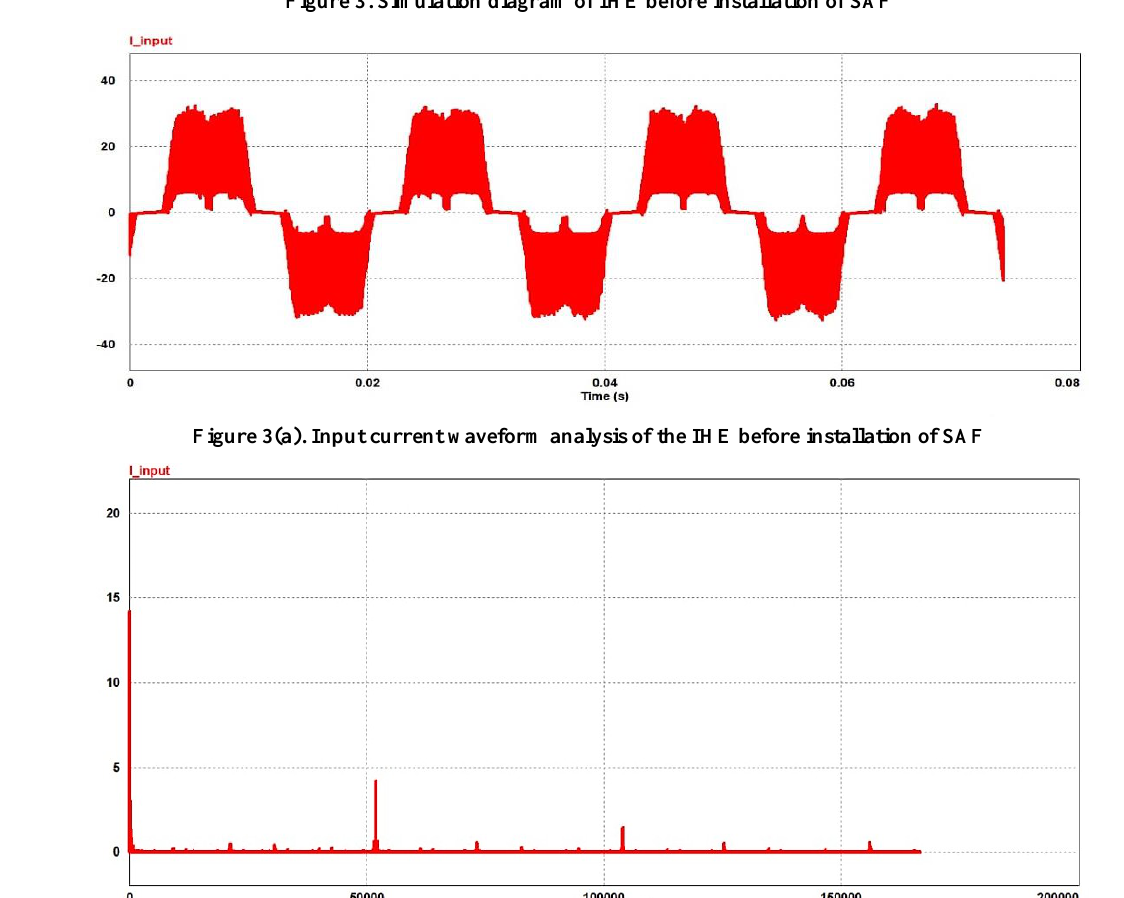
Figure 3. Simulation diagram of IHE before installation of SAF